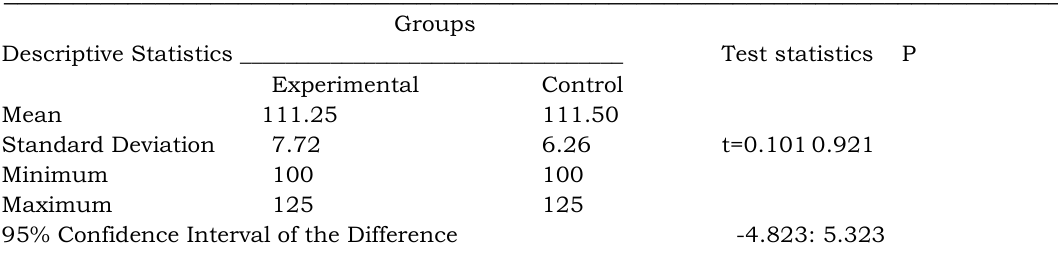
Table 1. Descriptive Statistics of Groups in Terms of Critical Thinking